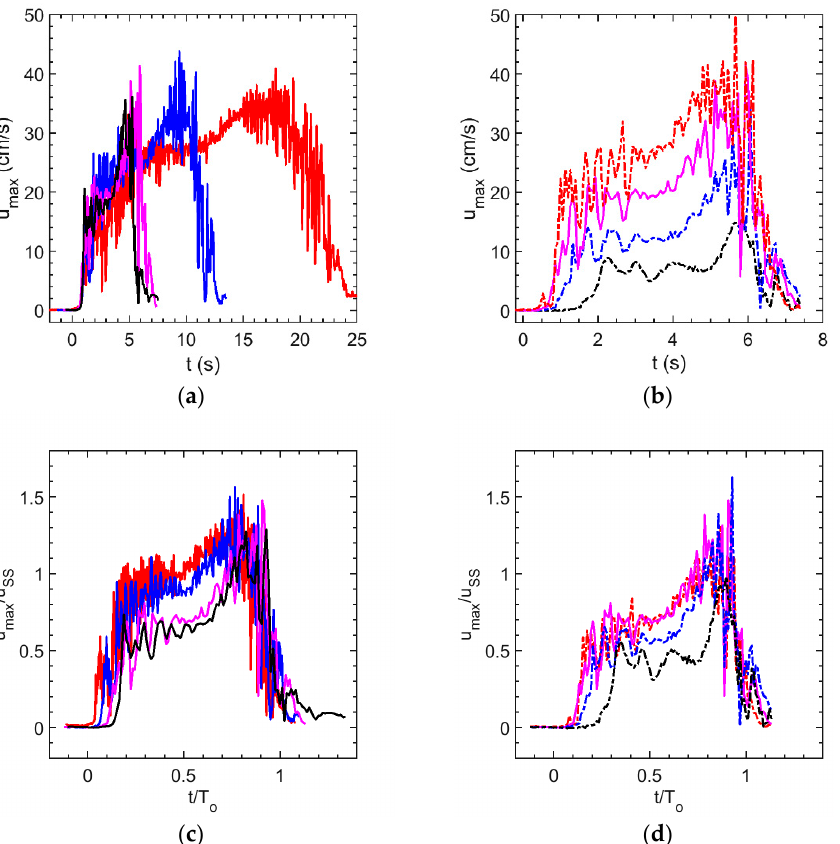
Figure 2. Exit velocity u max waveforms. Each panel shows a single realization for each of the cases studied. ( a ) u max vs time for u SS = 28 cm/s cases: red solid line, T o = 23.7 s; blue solid line, T o = 12.3 s; magenta solid line, T o = 6.53 s; black solid line, T o = 5.67 s. ( b ) u max vs time for T o = 6.53 s cases: red dash-dot line, u SS = 38 cm/s; magenta solid line, u SS = 28 cm/s; blue dash-dot line, u SS = 21.3 cm/s; black dash-dot line, u SS = 16.1 cm/s. Note that the T o = 6.53 s, u SS = 28 cm/s case (magenta solid line) appears in both ( a , b ). ( c ) Same data as in ( a ), but axes nondimensionalized (same legend). ( d ) same as ( b ), but axes nondimensionalized (same legend). Refer to Table 1 for corresponding Reynolds number and reduced frequency.